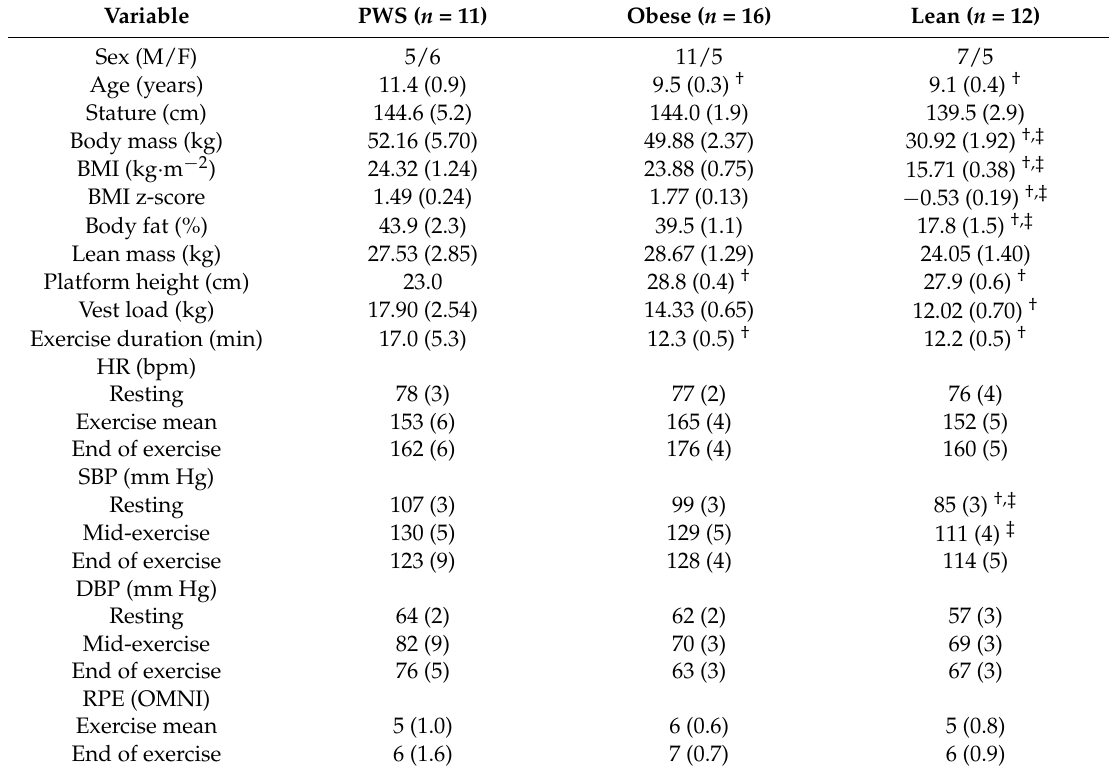
Table 1. Participant characteristics and responses to dynamic resistance exercise by group, presented as frequency or mean